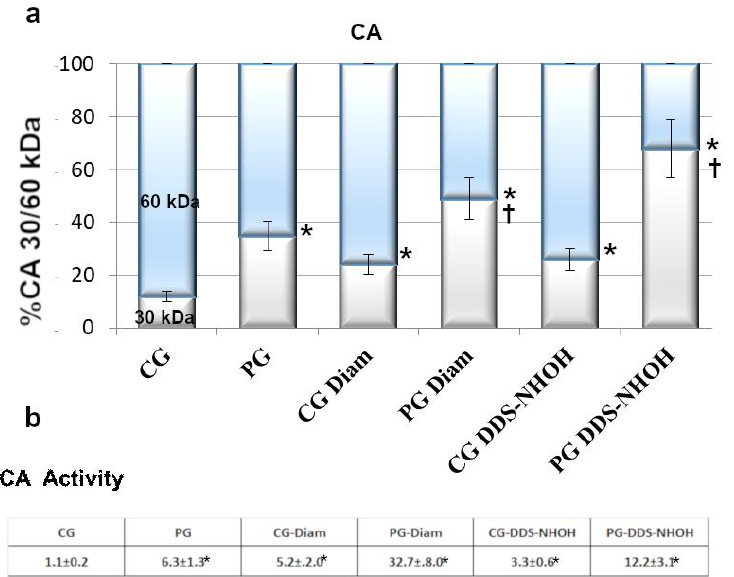
Figure 1. Fresh blood was collected from CG and PG RBCs (isolated as described in the Methods section) and was incubated with and without 1.5 mM diamide or 0.3 mM DDS-NHOH. ( a ) Diluted cytosol from 1 µ L of packed cells, underwent Western blotting in non-reducing conditions. Bands immunostained with anti-CA antibodies were densitometrically analyzed, and the sum of the 30 and 60 kDa bands was arbitrarily calculated as 100%, taking into account that amount of proteolytic 30 kDa bands accounts for half the larger bands. Values were expressed as the means ± SD of n = 12 CG and n = 18 PG patients. * p < 0.001, comparison of CA 30 kDa isoform before and after treatments within groups , Student’s t -test for paired data; † p < 0.001, comparison of the 30 kDa band between CG and PG groups, in both experimental conditions (diamide and DDS-NHOH treatments ), Student’s t -test. ( b ) CA activity: 300 µ L of diluted cytosol from CG or PG RBCs, previously incubated with and without 1.5 mM diamide or 0.3 mM DDS-NHOH, were assayed for activity as described in the Methods section. The activity was calculated as the ratio to activity observed in untreated CG (chosen as arbitrary comparison unit, experimentally determined as 1 ± 0.23, mean value ± SD). Data show the means ±SD of n = 12 CG and n = 18 PG patients. * p < 0.001, comparison of CA activity to CG , before and after diamide treatment, Student’s t -test for paired data.